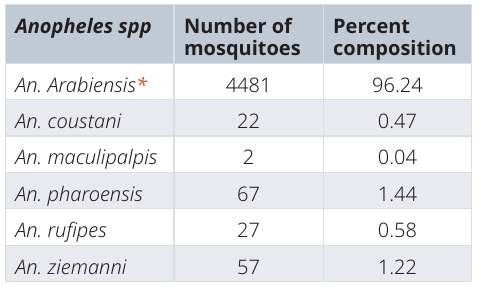
Table 2. Species composition of Anopheles collected from habitats along the lake shore of Rusinga